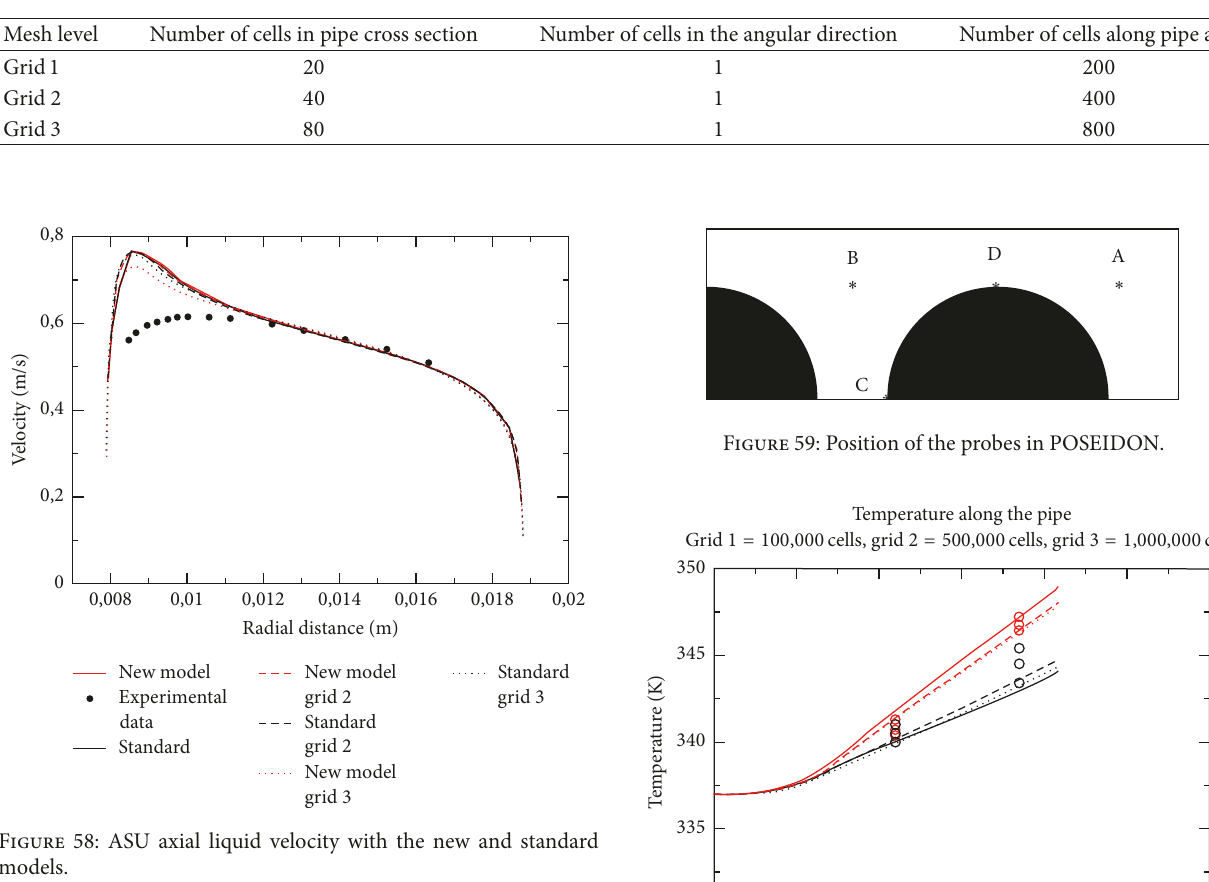
Table 9: Mesh refinement for the ASU experiment.